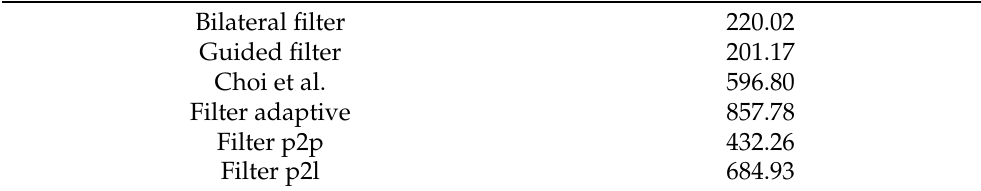
Table 1. Average running time